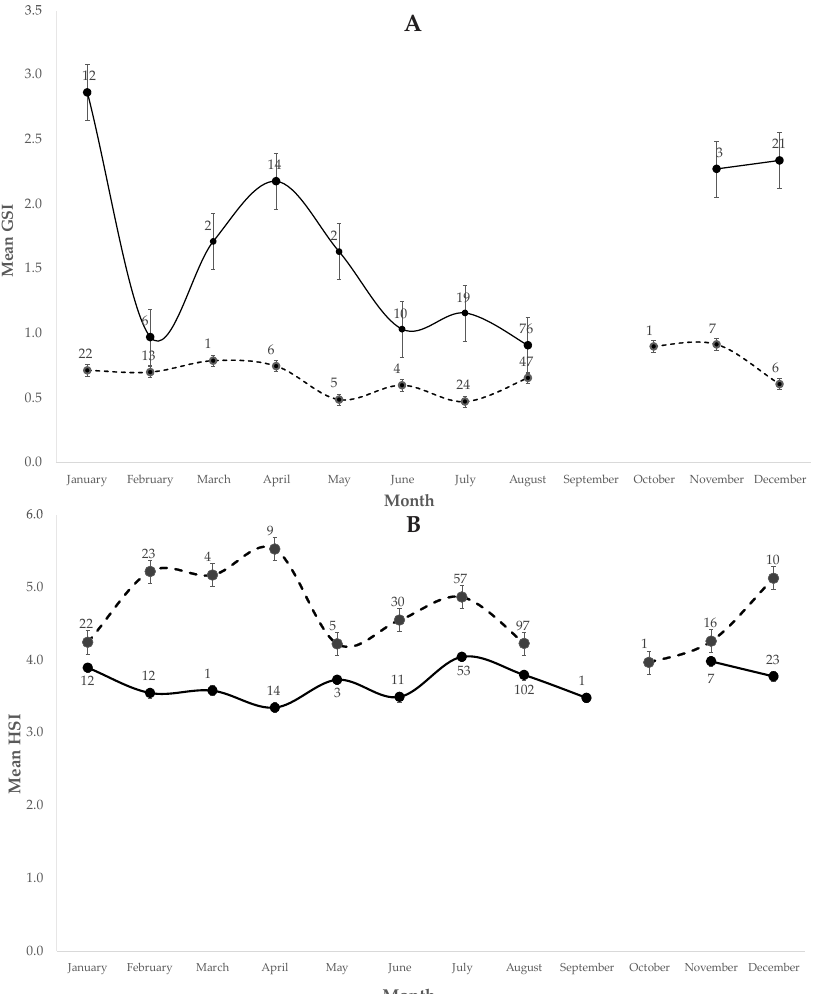
Figure 5. Gonadosomatic Index ( A , GSI) and Hepatosomatic Index ( B , HSI) for males (dashed line) and females (continuous line) of U. chilensis in the SGC. The bars represent the standard deviation, and the number is the N for that sex and month.